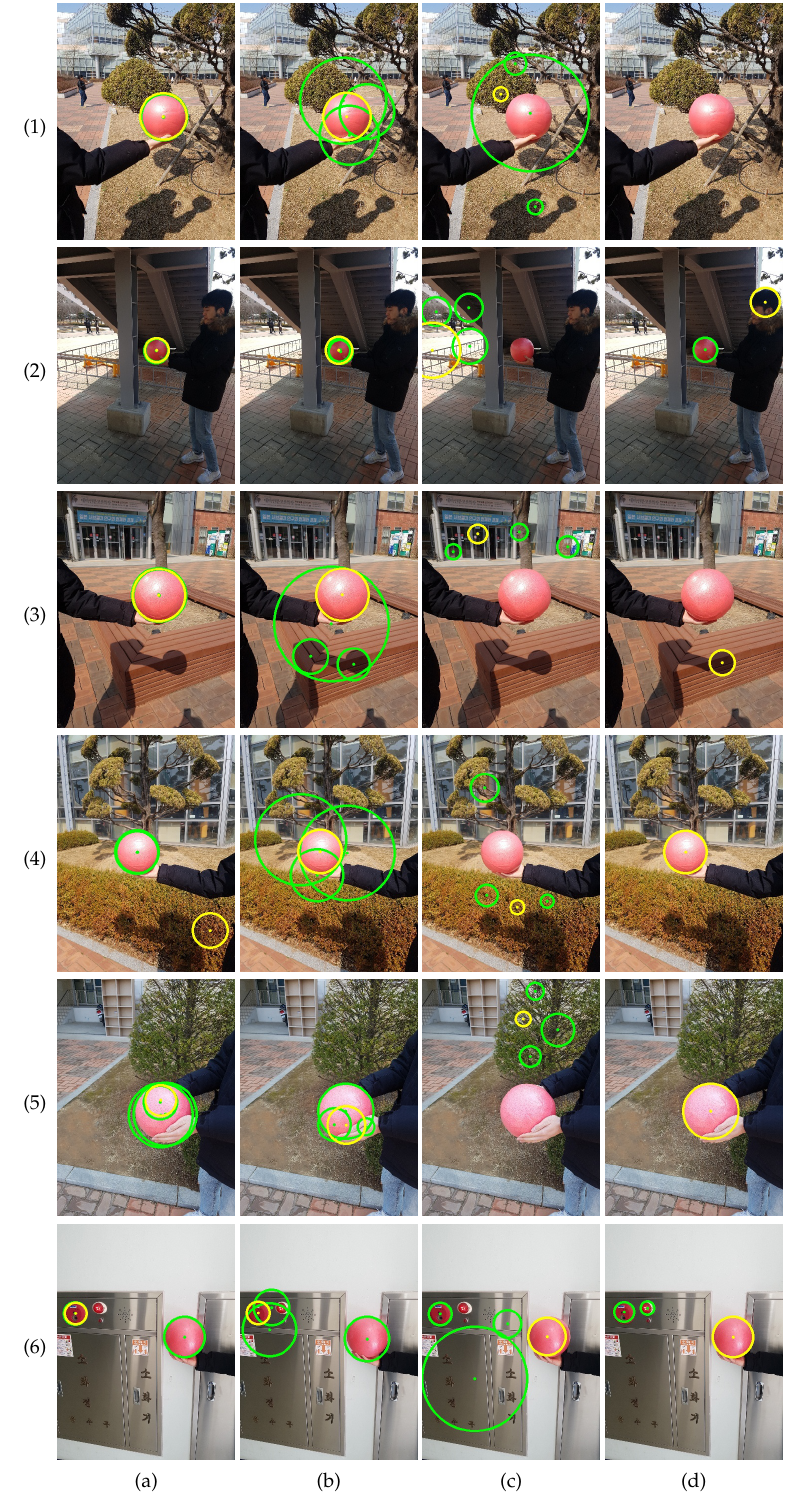
Figure 9. Top four circles detected by the methods (gym ball set). ( a ) Proposed method. ( b ) Kwon et al. [21]. ( c ) CHT [36]. ( d ) EDCircles [44]. From ( a – d ), the best circles are drawn in yellow, while the remaining circles are drawn in green. Some circles have similar centers and radii in ( a ) and ( b ), so the numbers of circles in the images may seem less than four. Best viewed in